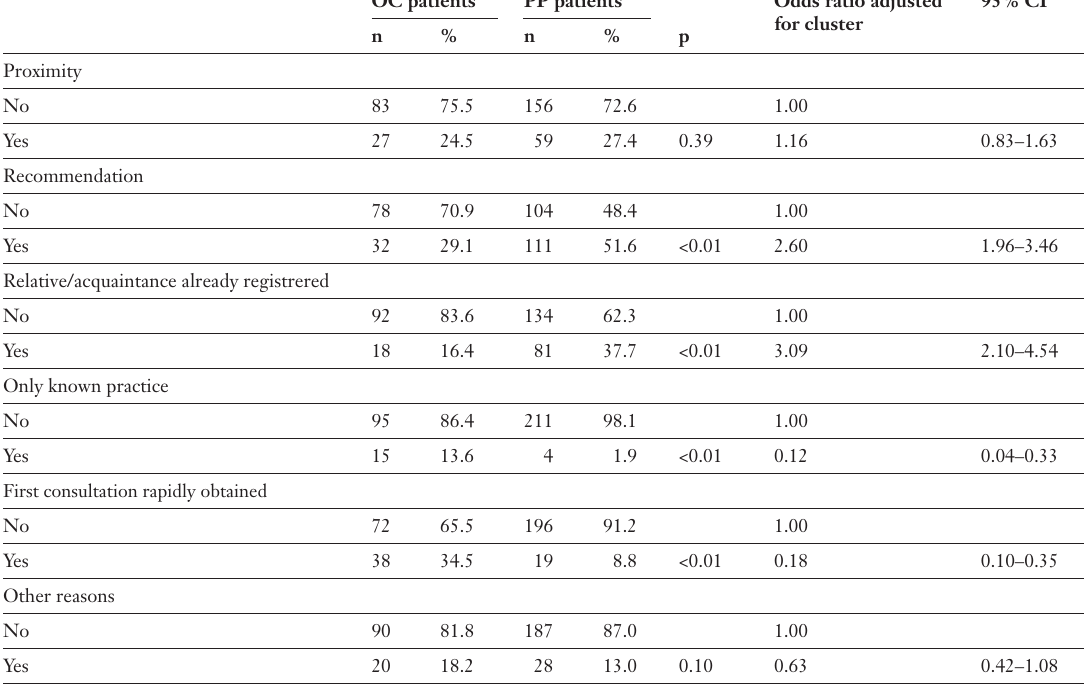
Table 2 Reasons for choosing a practice among university medical outpatient clinic (OC) patients and private practice (PP)